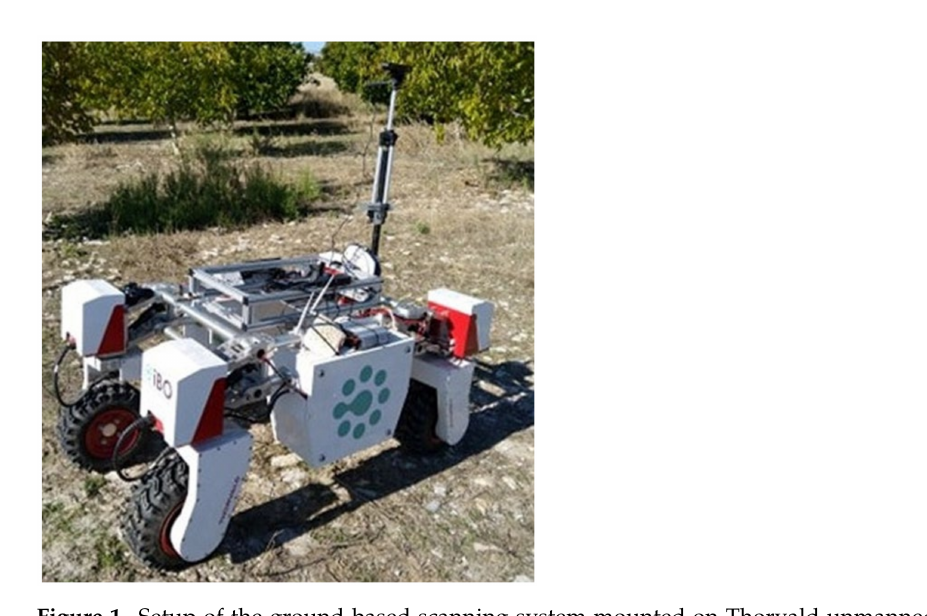
Figure 1. Setup of the ground-based scanning system mounted on Thorvald unmanned ground